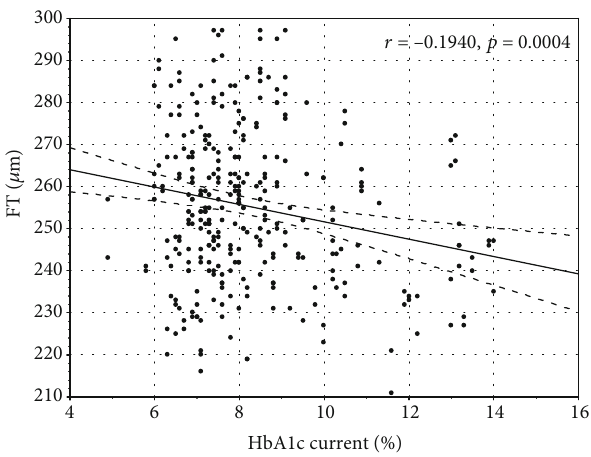
Figure 4: The correlation between mean average glycated hemoglobin A1c and parafoveal